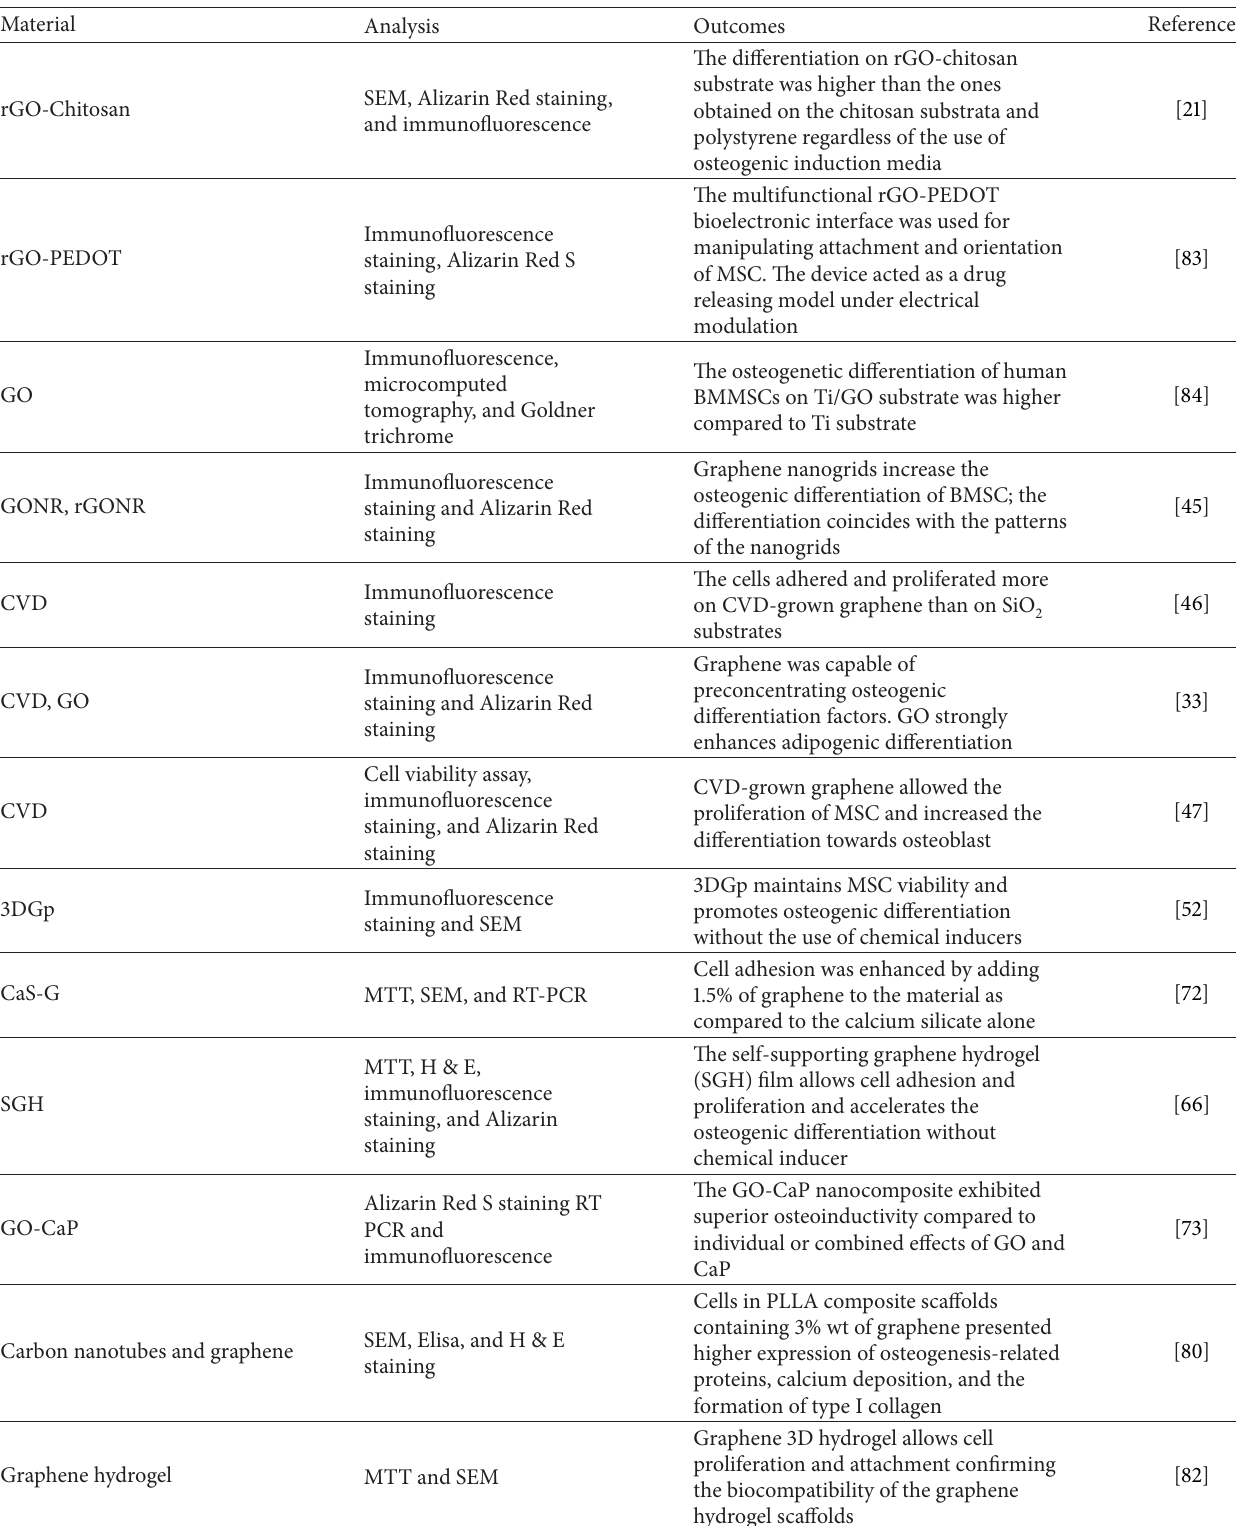
Table 1: Summary of studies using graphene for